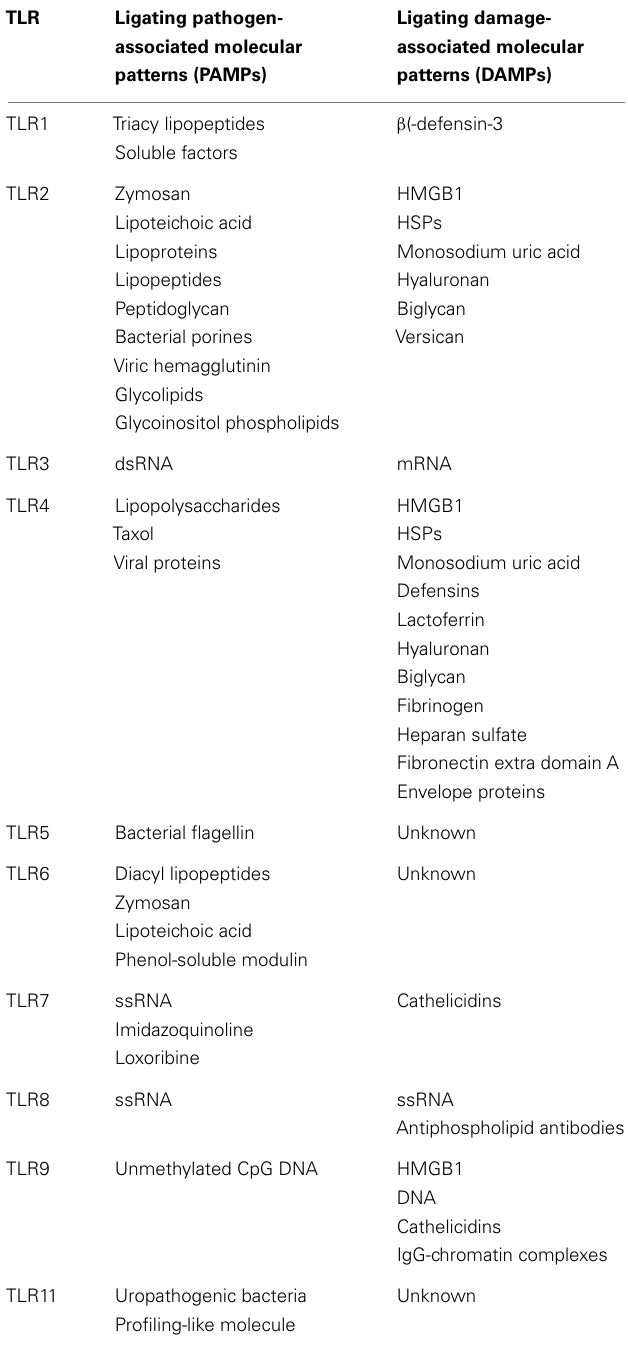
Table 1 | Human homodimeric toll-like receptors, PAMPs, and DAMPs that can be recognized by the differentTLRs (Fritz and Girardin, 2005; Piccinini and Midwood, 2010; Basith et al., 2011; Rosin and Okusa, 2011; Liu and Ji, 2014)